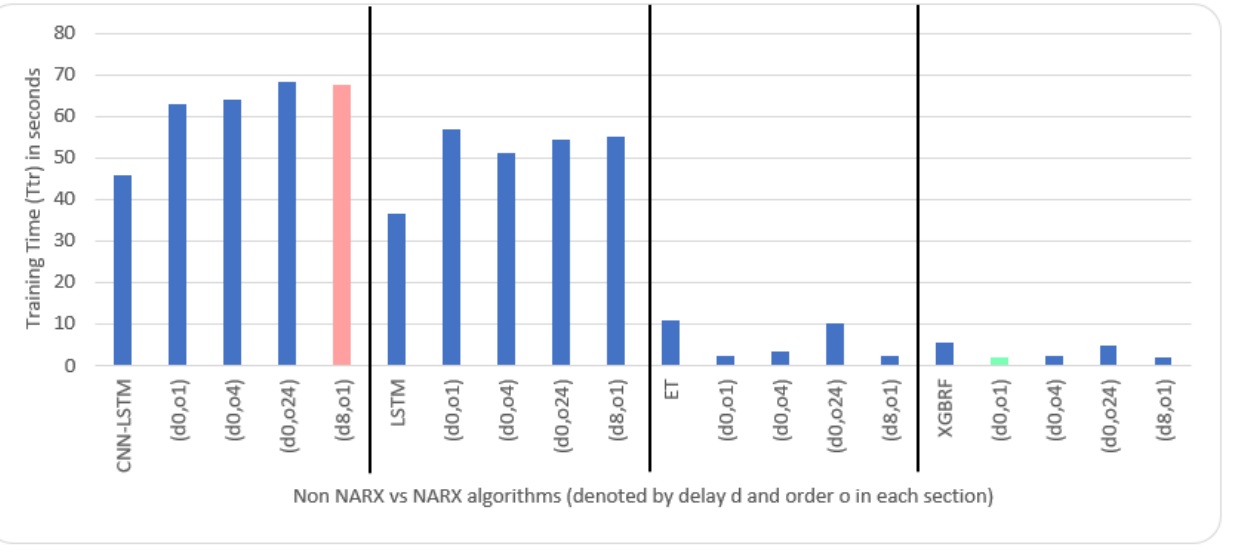
Figure 31. Evaluation results of non-NARX and NARX in terms of offline training time for the Manchester dataset.